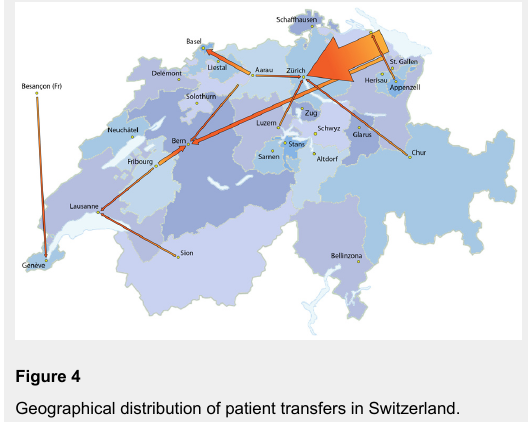
Geographical distribution of patient transfers in Switzerland. Transfers within France and Germany are not shown. Arrow size is proportional to the number of transfers. Thin arrows represent the transfer of 1 patient; arrows twice this width represent transfer of 2 patients; the large arrow from eastern Switzerland to Zurich represents the transfer of 21